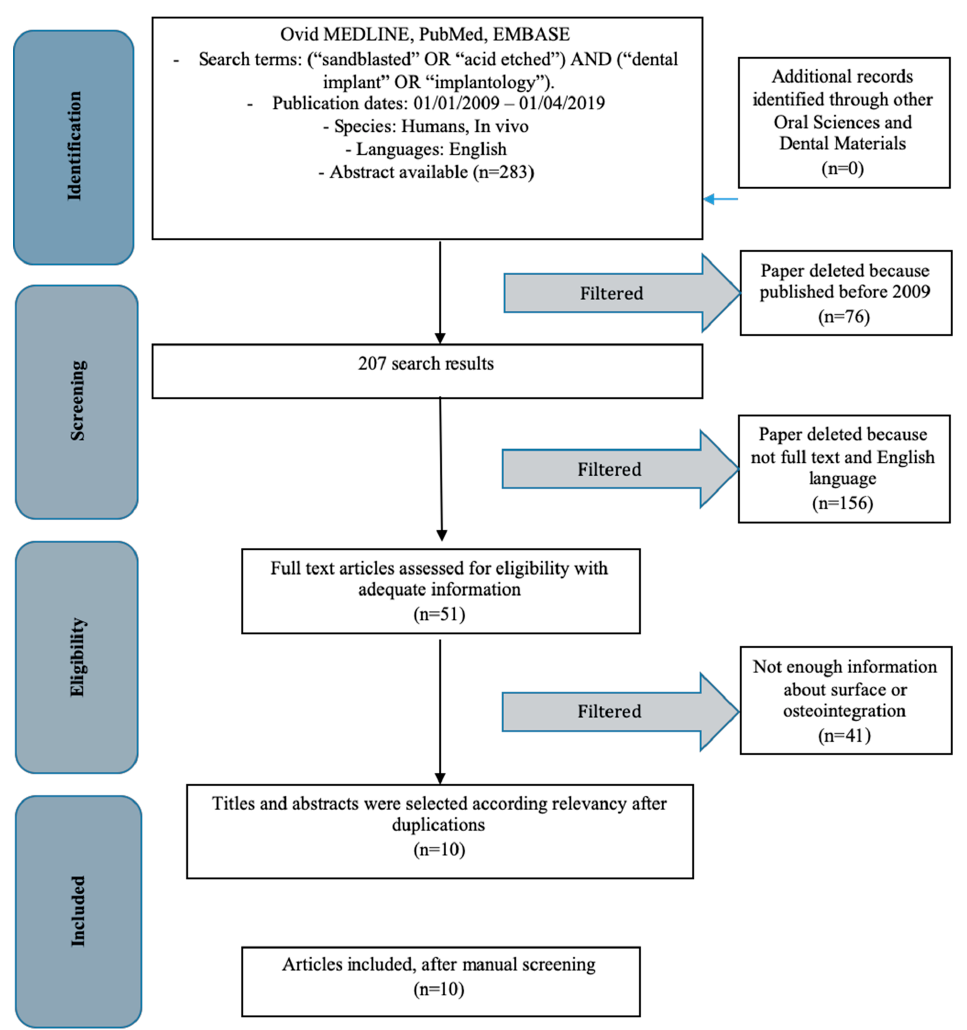
Figure 8. PRISMA flow chart.